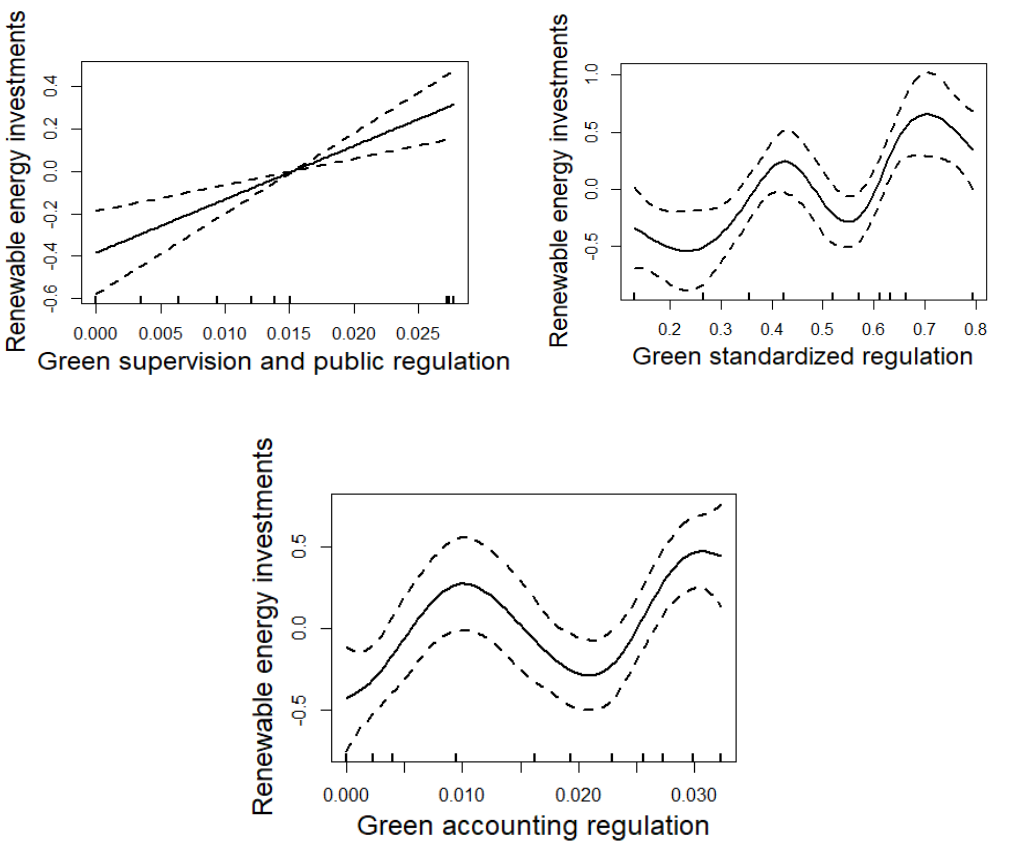
Figure 3. Effect of three kinds of environmental policies on investments in renewable energy